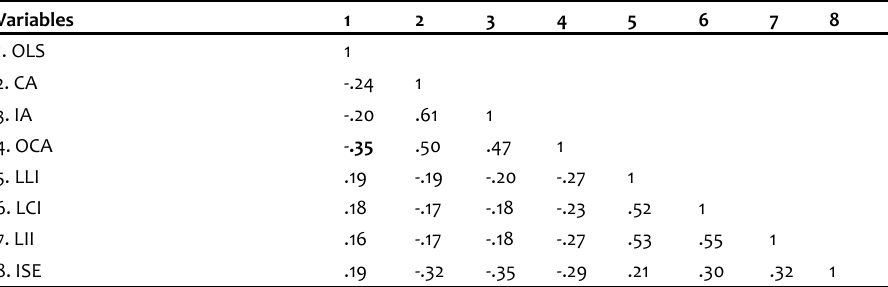
Table 3. Correlation Matrix of the Variables